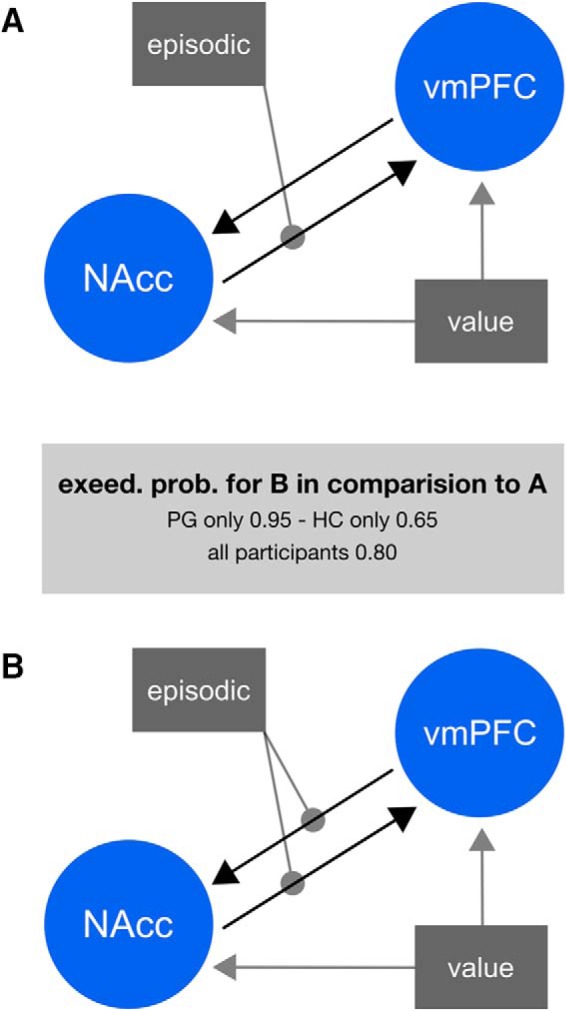
Model families to describe vmPFC and NAcc interactions. All models grouped in family A assume no modulation of the vmPFC to NAcc connection by the episodic condition. All models in family B assume such a modulation. Gray arrows denote connections, modulations or driving inputs that may or may not exist. Exceed. prob., exceedance probability (see Results for more details). PG, pathological gamblers; HC, healthy controls.